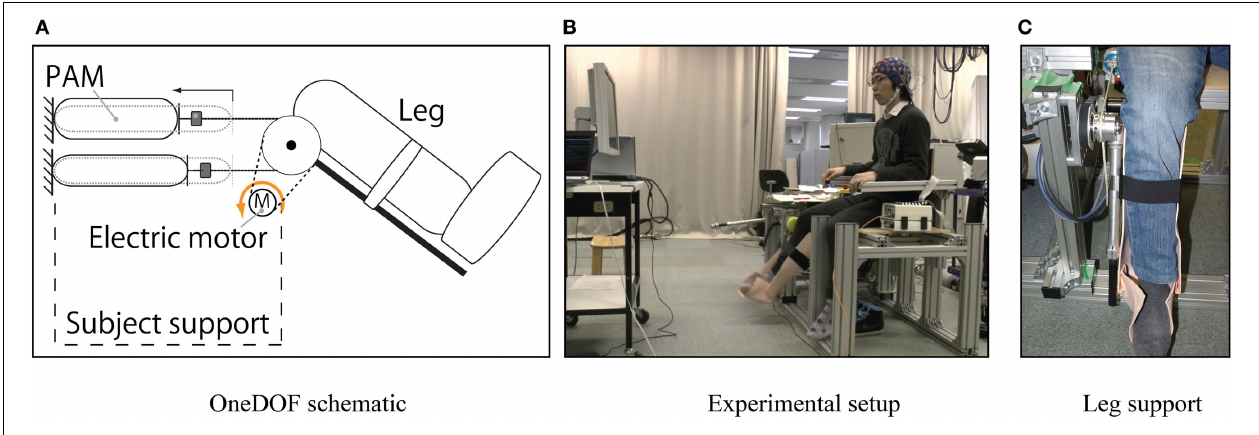
( Figure 3 ) consisting of two factors: “finger tapping task” and “leg condition.” The former is divided into three levels, being left tap- ping, right tapping and idle; while the latter is composed by two levels: NoPert and Pert .